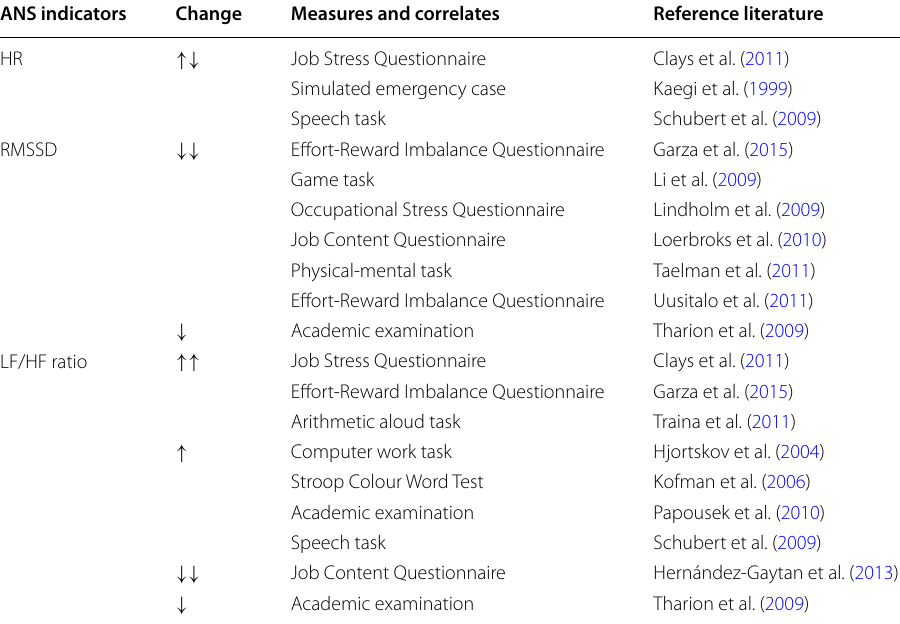
( ) significant lower (higher) under stress ( p < 0.05): ↓↓ ↑↑ (heart rate), LF (low frequency domain) / HF (high frequency domain) ratio, RMSSD (square root of the mean of the sum of the squares of differences between adjacent NN (normal‑to‑normal) intervals); overview adapted from Castaldo et al. (2015), Jaervelin‑Pasanen et al. (2018), and Kim et al.